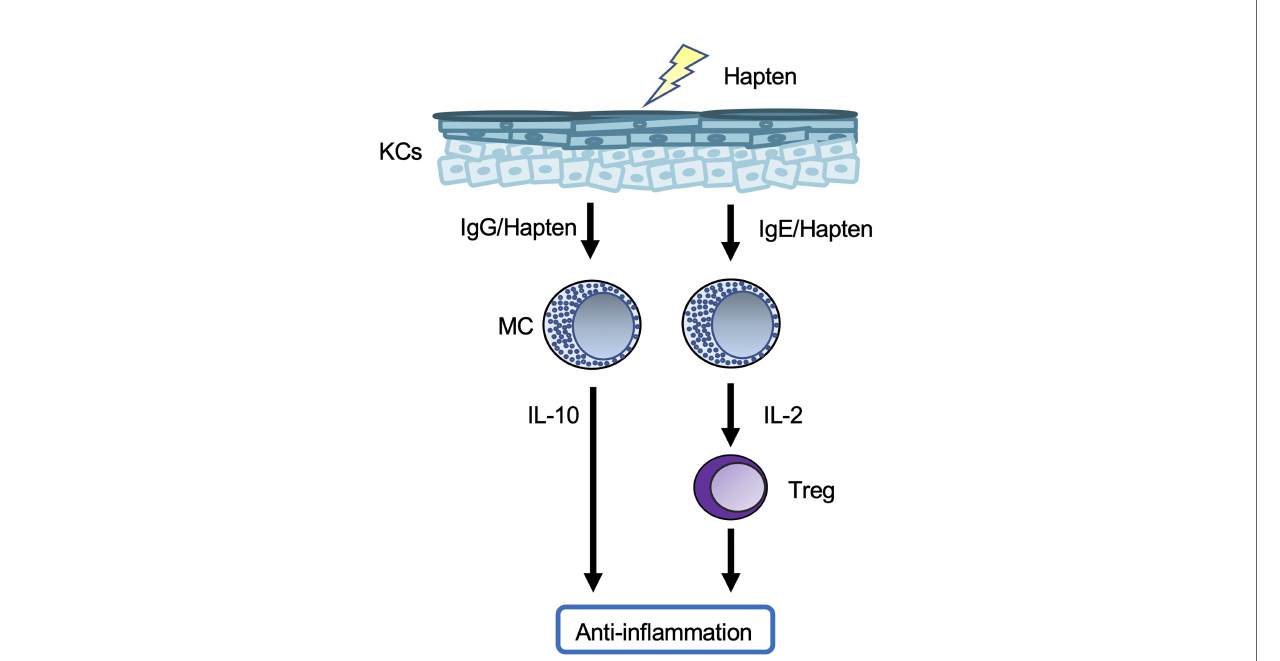
FIGURE 3 | Mast cells in chronic contact hypersensitivity. In one chronic contact hypersensitivity (CHS) setting, crosslinked hapten/hapten-speci fi c IgG complexes stimulate skin mast cells (MCs) to produce IL-10, which leads to suppression of the in fl ammation. In another chronic CHS setting, crosslinking of hapten/hapten- speci fi c IgE/Fc ϵ R1 results in production of IL-2 by splenic MCs, which leads to expansion of Tregs in the spleen. The Tregs migrate from the spleen to local skin lesions, where they suppress the in fl